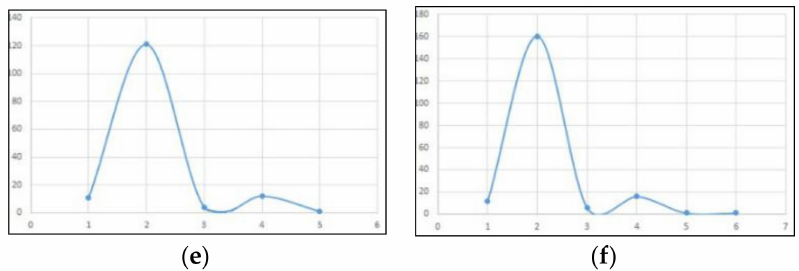
Figure 2. Evolution of node degree distribution in the Wuhan rail transit network. ( a ) 2014; ( b ) 2015; ( c ) 2016; ( d ) 2017; ( e ) 2018; ( f ) 2019; Horizontal axis represents the degree distribution of nodes and vertical axis represents the number of stations.